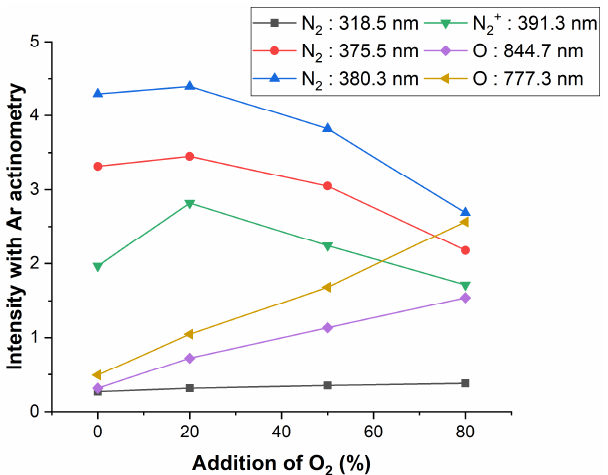
Figure 5. N 2 + O 2 plasma peak intensity change with the addition of O 2 . In the case of NF 3 plasma, the spectrum is very similar to that of N 2 plasma. The presence of the N 2 second positive system at 300–400 nm and the N 2 first positive system